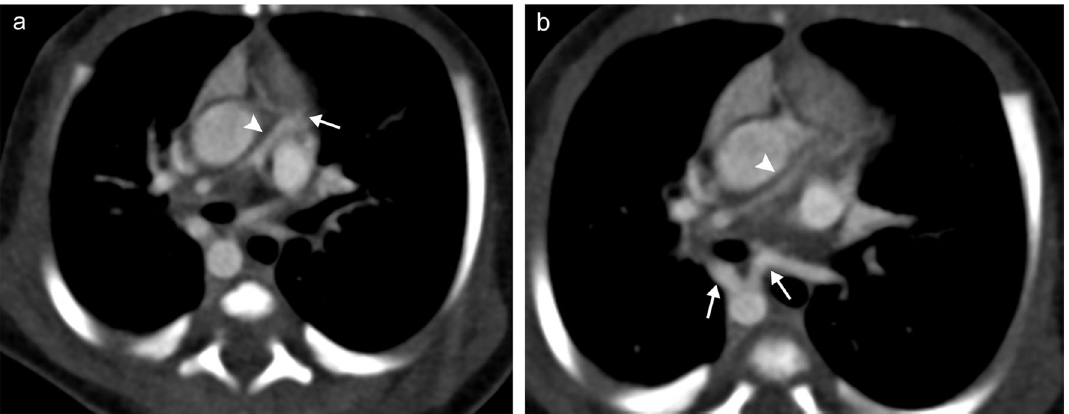
Fig. 2 Pulmonary artery atresia. a Axial CT image demonstrating abrupt termination of the main pulmonary artery ( white arrow ) in a patient with tetralogy of Fallot with a small hypoplastic distal pulmonary artery ( white